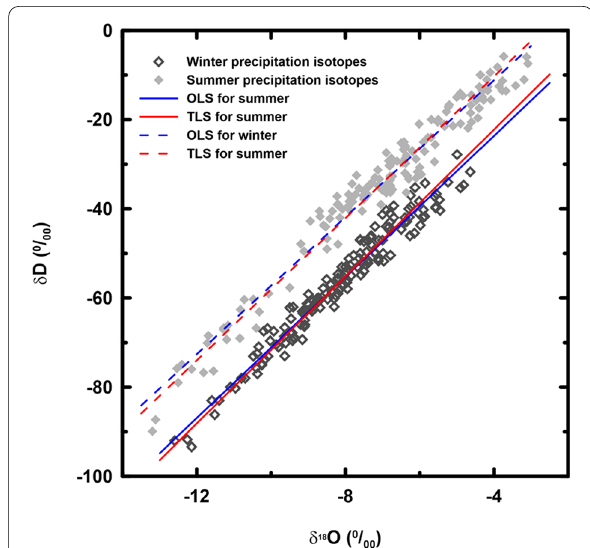
Fig. 3 Isotopic compositions of summer and winter rainfall from Jeju volcanic island, Jeju, Korea. Two local meteoric water lines (LMWL) are observed